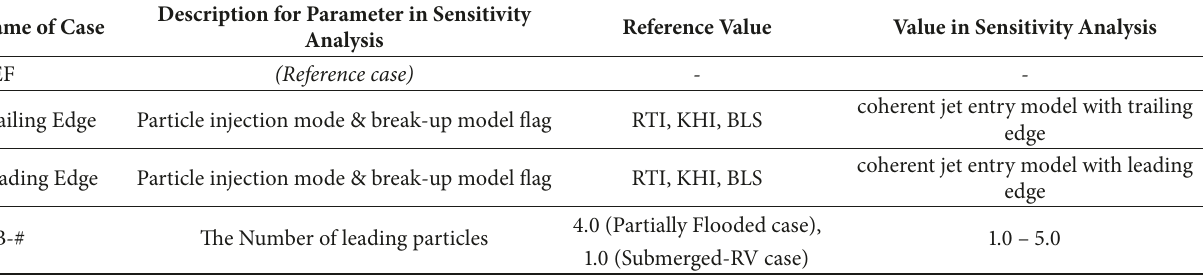
Table 2: Cases and parameters in sensitivity